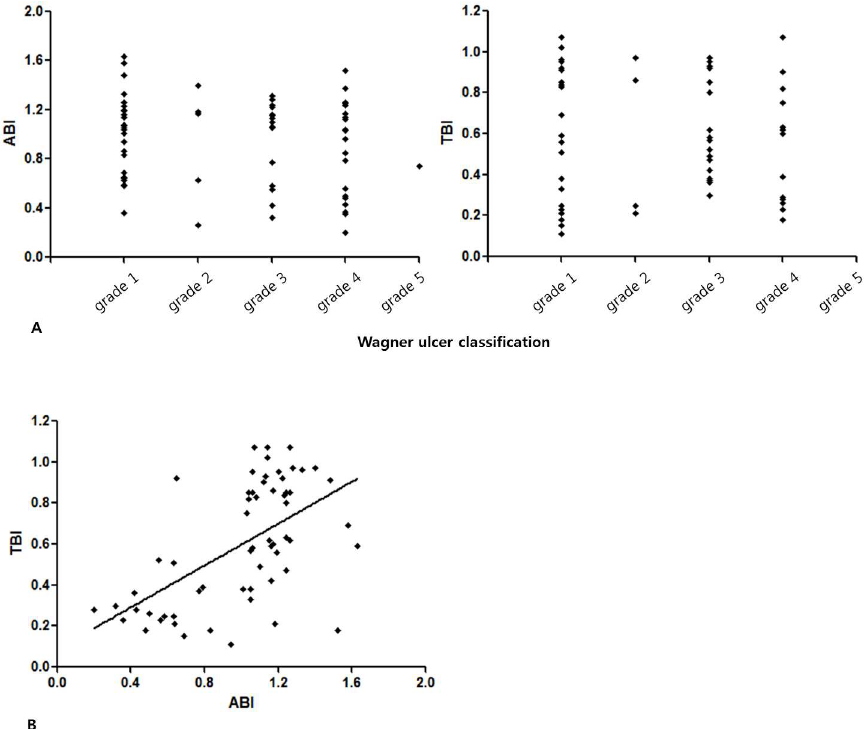
Fig 2. The associations between the Wagner ulcer classification system, ankle-brachial index (ABI), and toe-brachial index (TBI). (A) The Wagner ulcer classificationsystem and ABI/TBI showedno correlation (p = 0.178 and 0.295, respectively). (B) The ABI and TBI showeda significantcorrelation(R = 0.573, p <